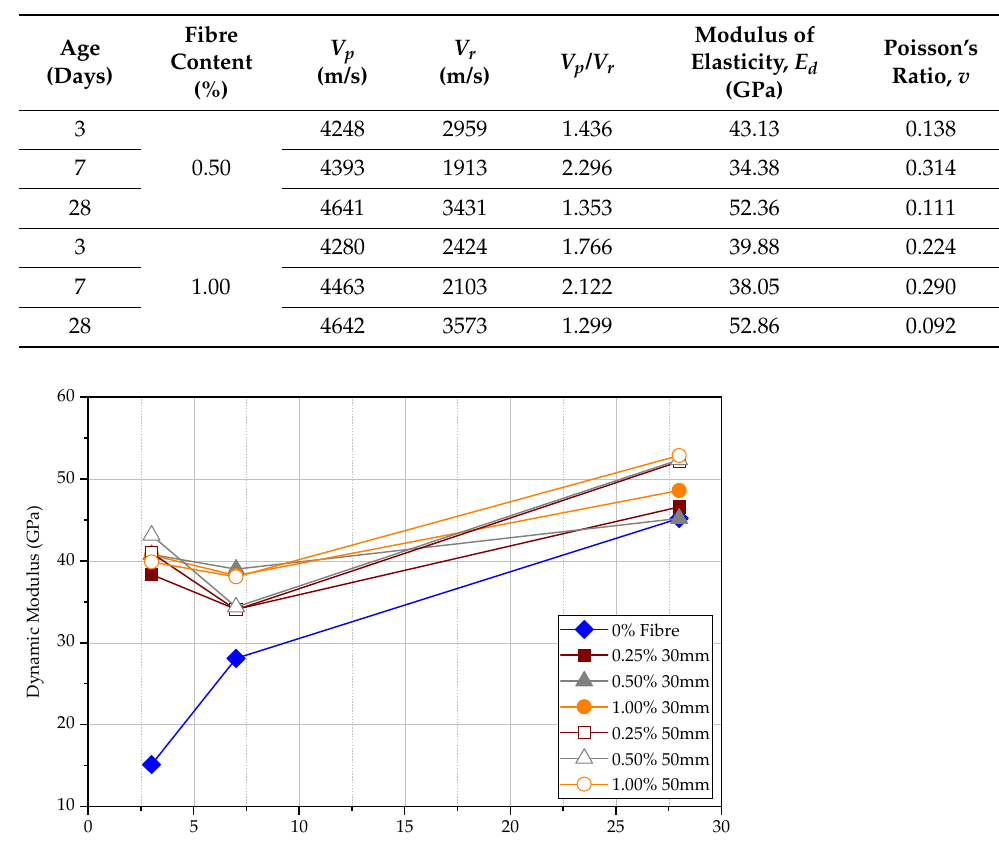
Figure 21. The modulus of elasticity (GPa) of beams at 3, 7, and 28 days.